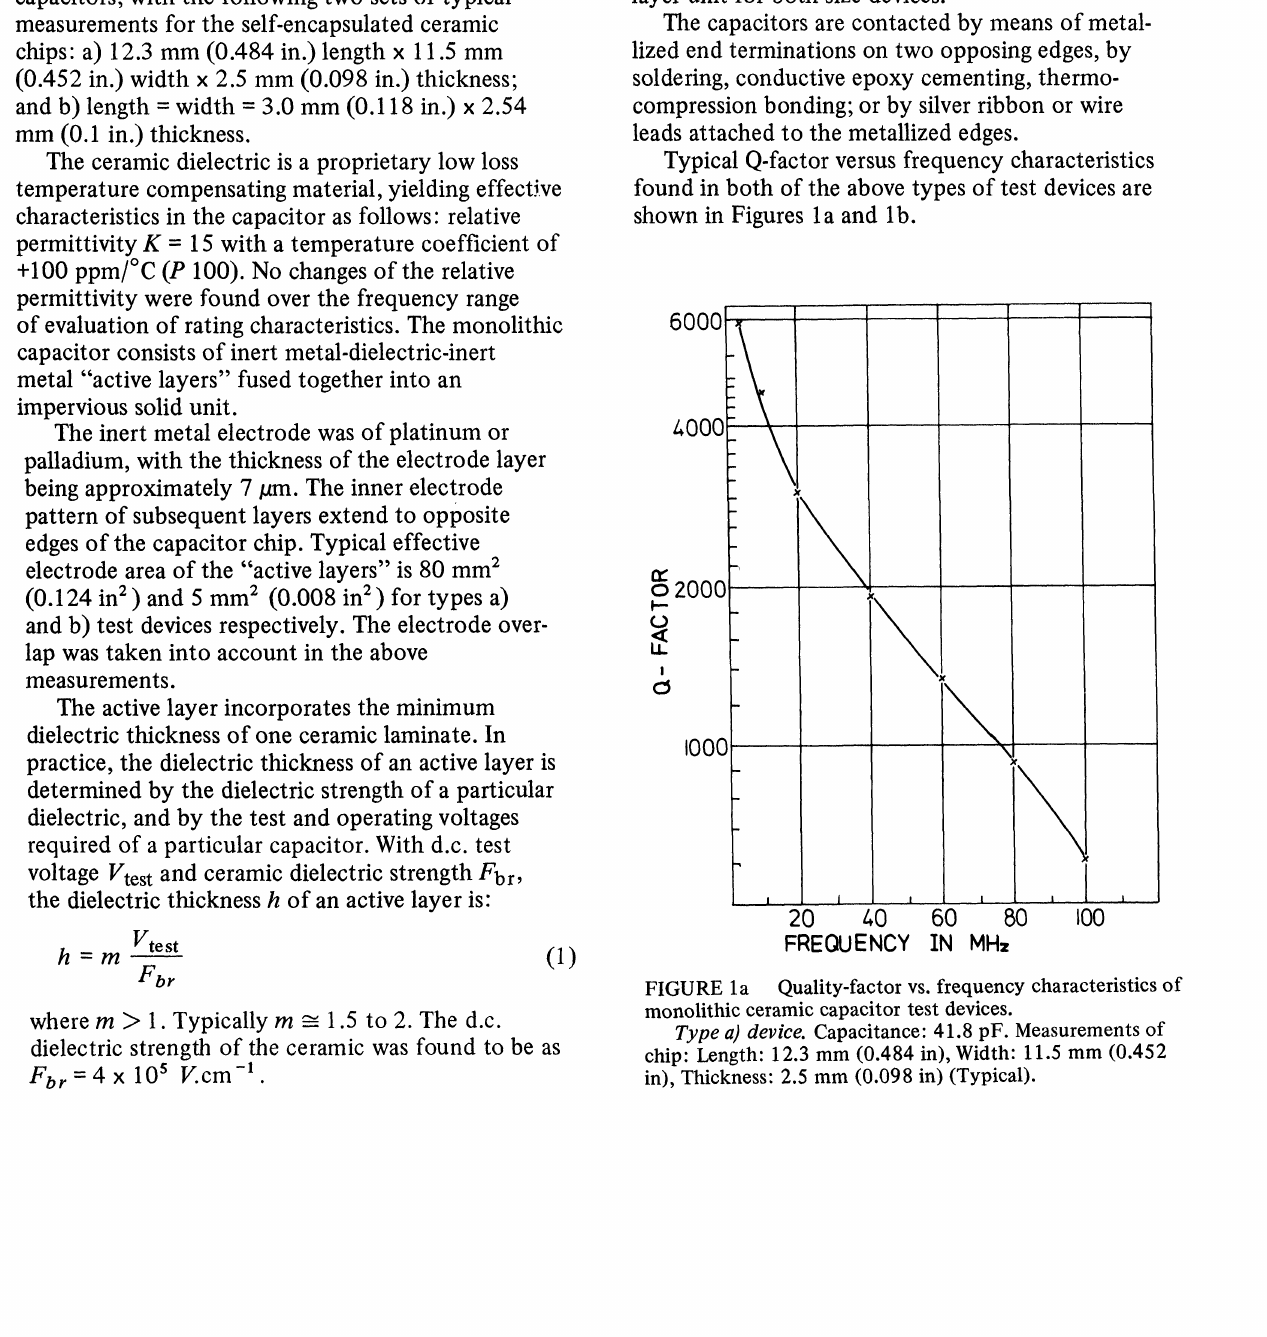
Quality-factor vs. frequency characteristics of monolithic ceramic capacitor test devices. Type a) device. Capacitance: 41.8 pF. Measurements of chip: Length: 12.3 mm (0.484 in), Width: 11.5 mm (0.452 in), Thickness: 2.5 mm (0.098 in)